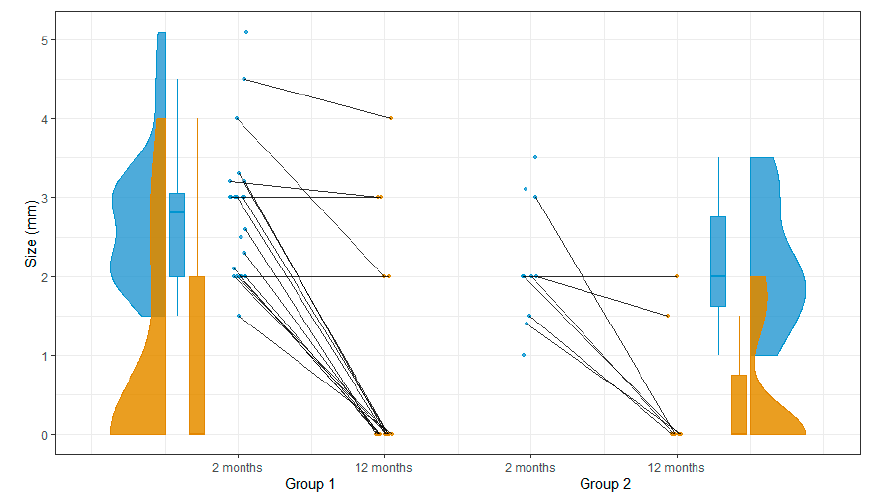
Figure 3. Occlusion of patent iASD. iASD = iatrogenic atrial septal defect. Even after adjustment for the CHA 2 DS 2 -VASc and HASBLED scores, we found no relationship between ICE-guided LAAC and the development of iASD (adjusted OR: 1.588 (95%CI, 0.696–3.623; p = 0.272)). We also found no relationship between ICE-guided LAAC and the development of iASD after adjustment for demographic characteristics (age, sex, and BMI); certain underlying diseases (non-paroxysmal AF, AF duration, heart failure, hypertension, diabetes mellitus, prior ischemic stroke, and coronary heart disease); the echocardiographic index (LAD, LVEF, pulmonary hypertension, pathological mitral, and tricuspid regurgitation); and peri-procedure characteristics (PFO closure and the use